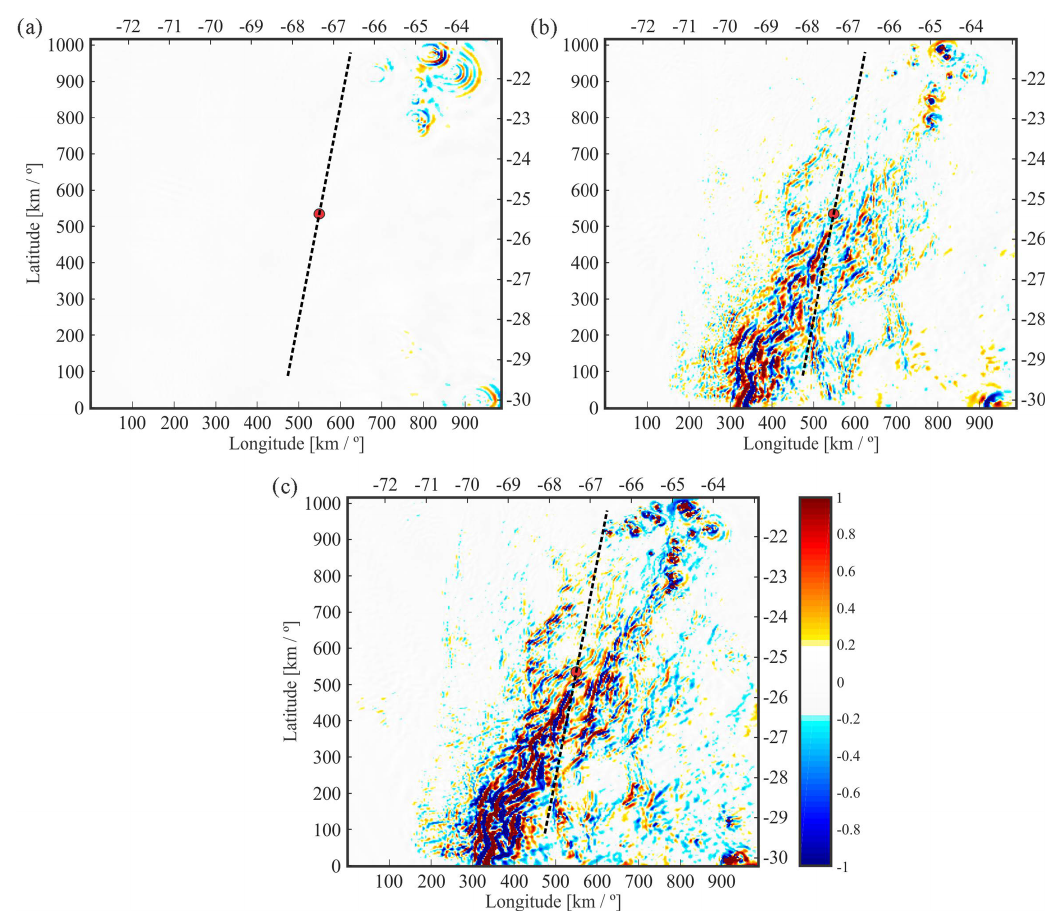
Figure 8. Simulated high-resolution GW structures in the Andes region defined in Fig. 1. Three constant altitudes are selected: (a) 26km, (b) 16km, and (c) 10km (respectively above, above, and below the cloud tops, situated at 14km). In this case, the mean LTP (black line) is located around 25.5 ◦ S, 67.1 ◦ W. The red point indicates the mean TP. The dotted line indicates the LOS crossing the TP corresponding to each selected